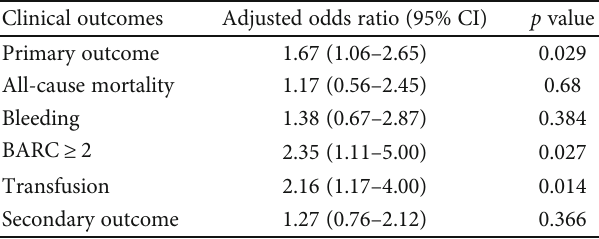
Table 3: The association between advanced thrombocytopenia ( platelet count ≤ 85 × 10 9 /L ) and the occurrence of clinical